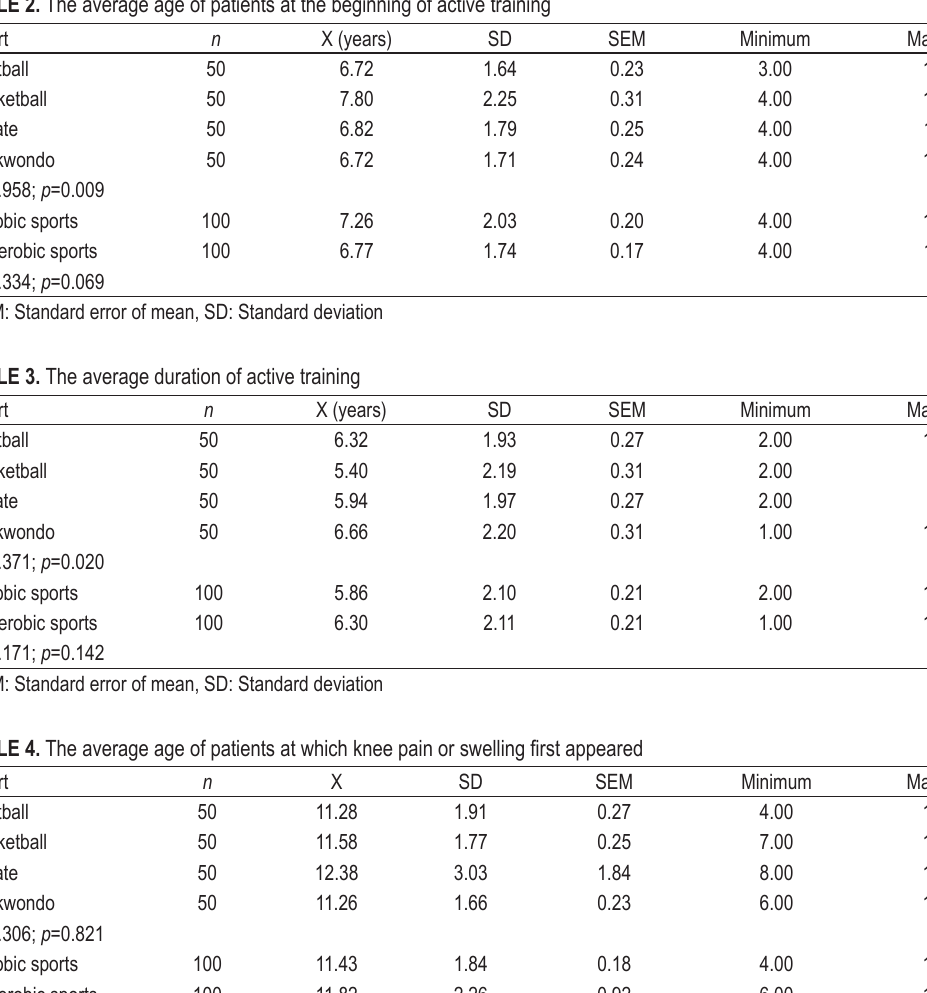
TABLE 2. The average age of patients at the beginning of active training Sport n SEM